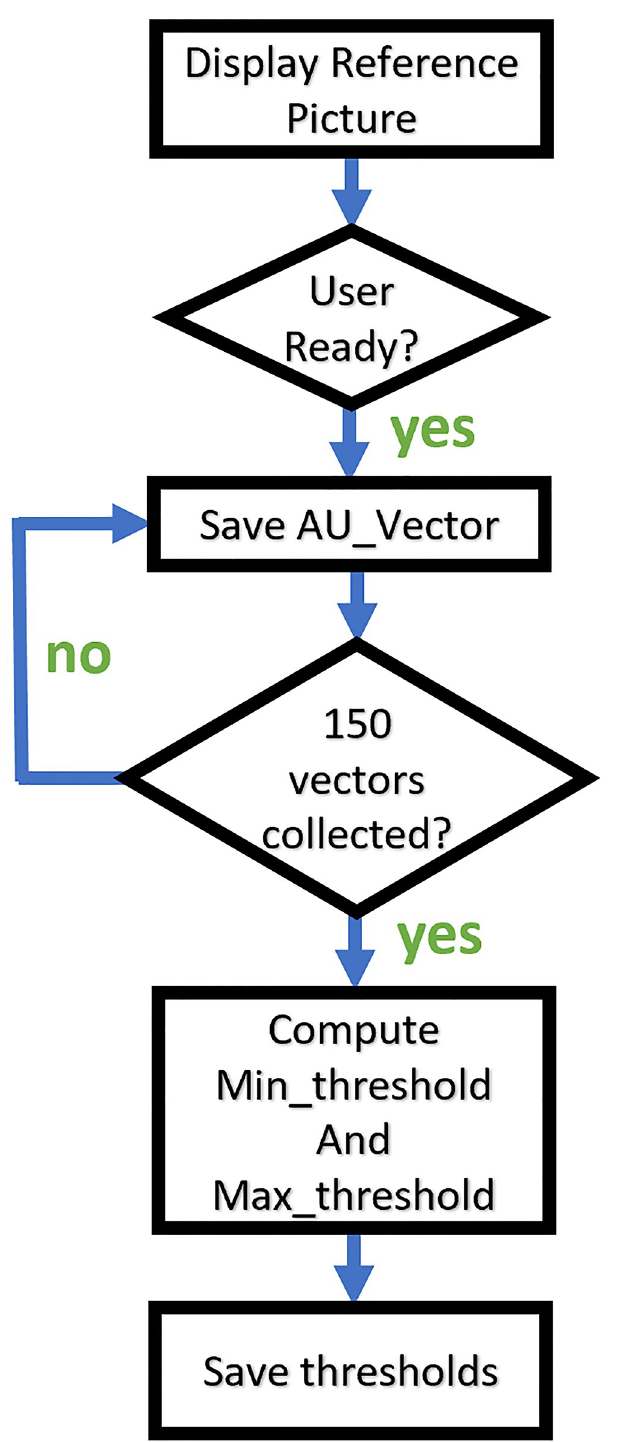
Fig 3. Calibration phase flowchart for one reference picture.